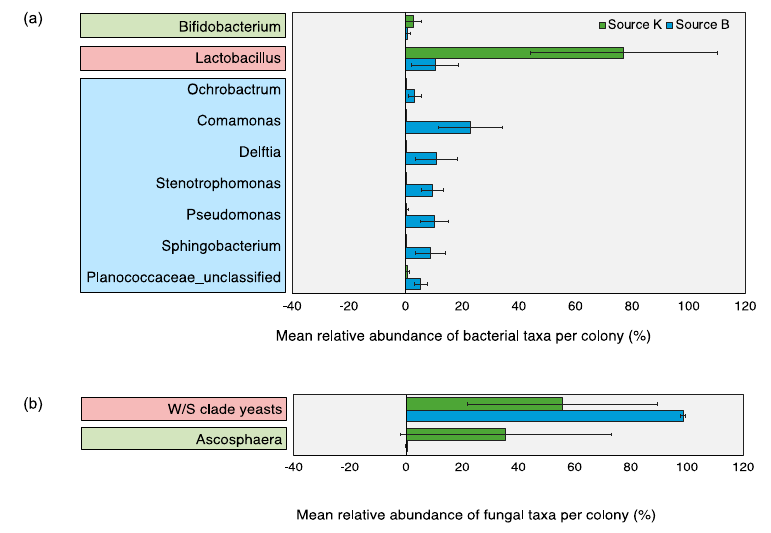
Figure 3. Relative abundance of core ( a ) bacterial and ( b ) fungal taxa detected within pollen provisions of bumble bee hives from Source K (green bars) and Source B (blue bars) (Mean ± 1SD). Microbial OTUs that showed > 50% prevalence and > 1% relative abundance across all replicates within each source were assigned as core microbiota (based on Graystock et al [79]). Core microbiota of Source K hives are enclosed within green boxes, that of Source B hives are enclosed within blue boxes, and the shared core microbiota across both sources are enclosed within red boxes.